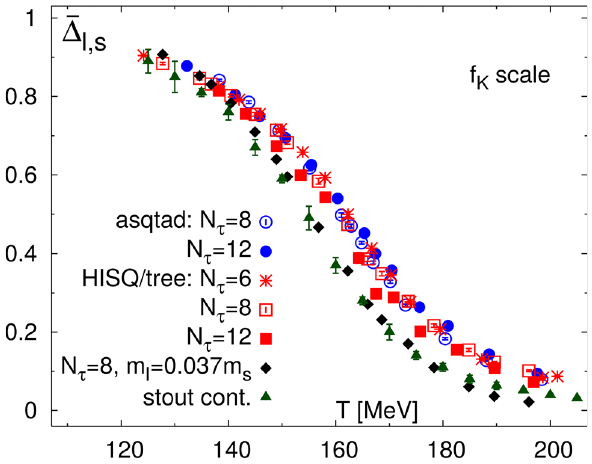
Fig. 4 Subtracted quark condensate normalized to its value at zero temperature as given in [6]. At T c , ¯ (cid:13) l , s has reduced its value by half and only at higher temperatures it shows an asymptotic vanishing behavior compatible with O ( 4 ) × U ( 1 ) A restoration. Figure taken from